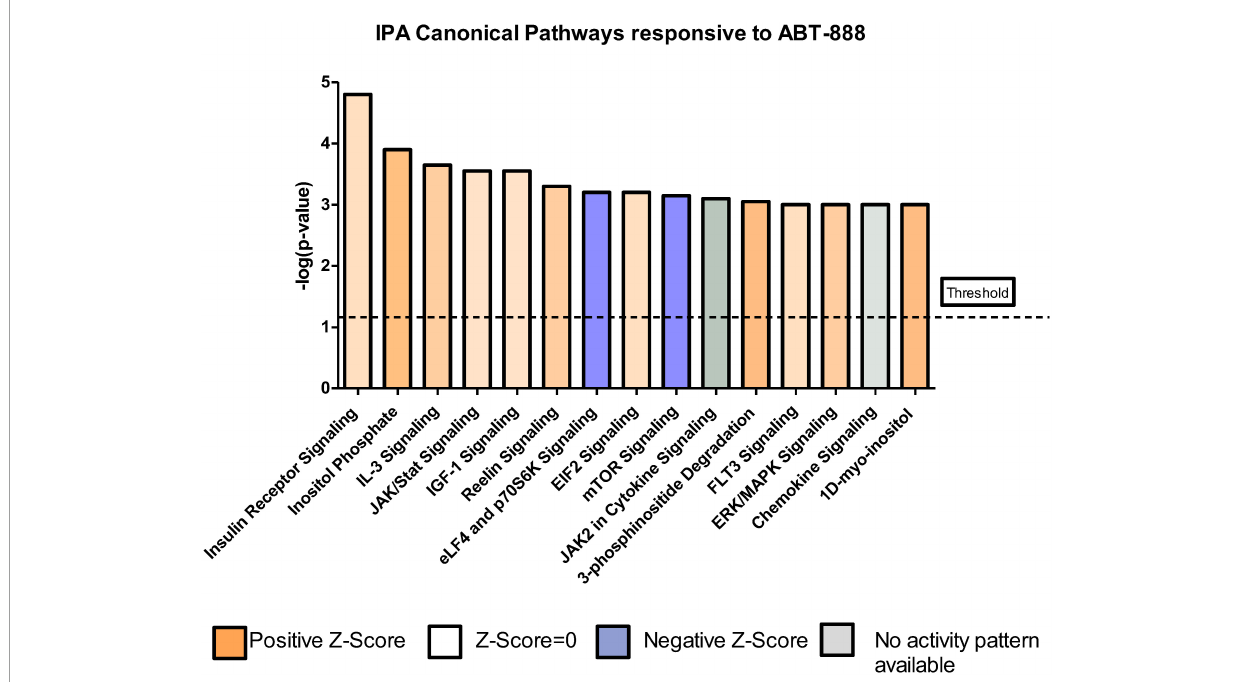
FIGURE5 Top canonical pathways emerging from the data where the effects of ethanol are reversed with ABT-888 in RE samples. IPA identified 15 significant canonical pathways (ranked based on –log p -value) in the list of 1115 transcripts from the RE (TRAP-seq) data that were ‘reversed by co-administration of EtOH + ABT-888’. Blue = negative z-score = –2 and impact on the pathway; orange = positive z-score = +2 and impact on the pathway; white = z-score = 0, signifying no impact on the